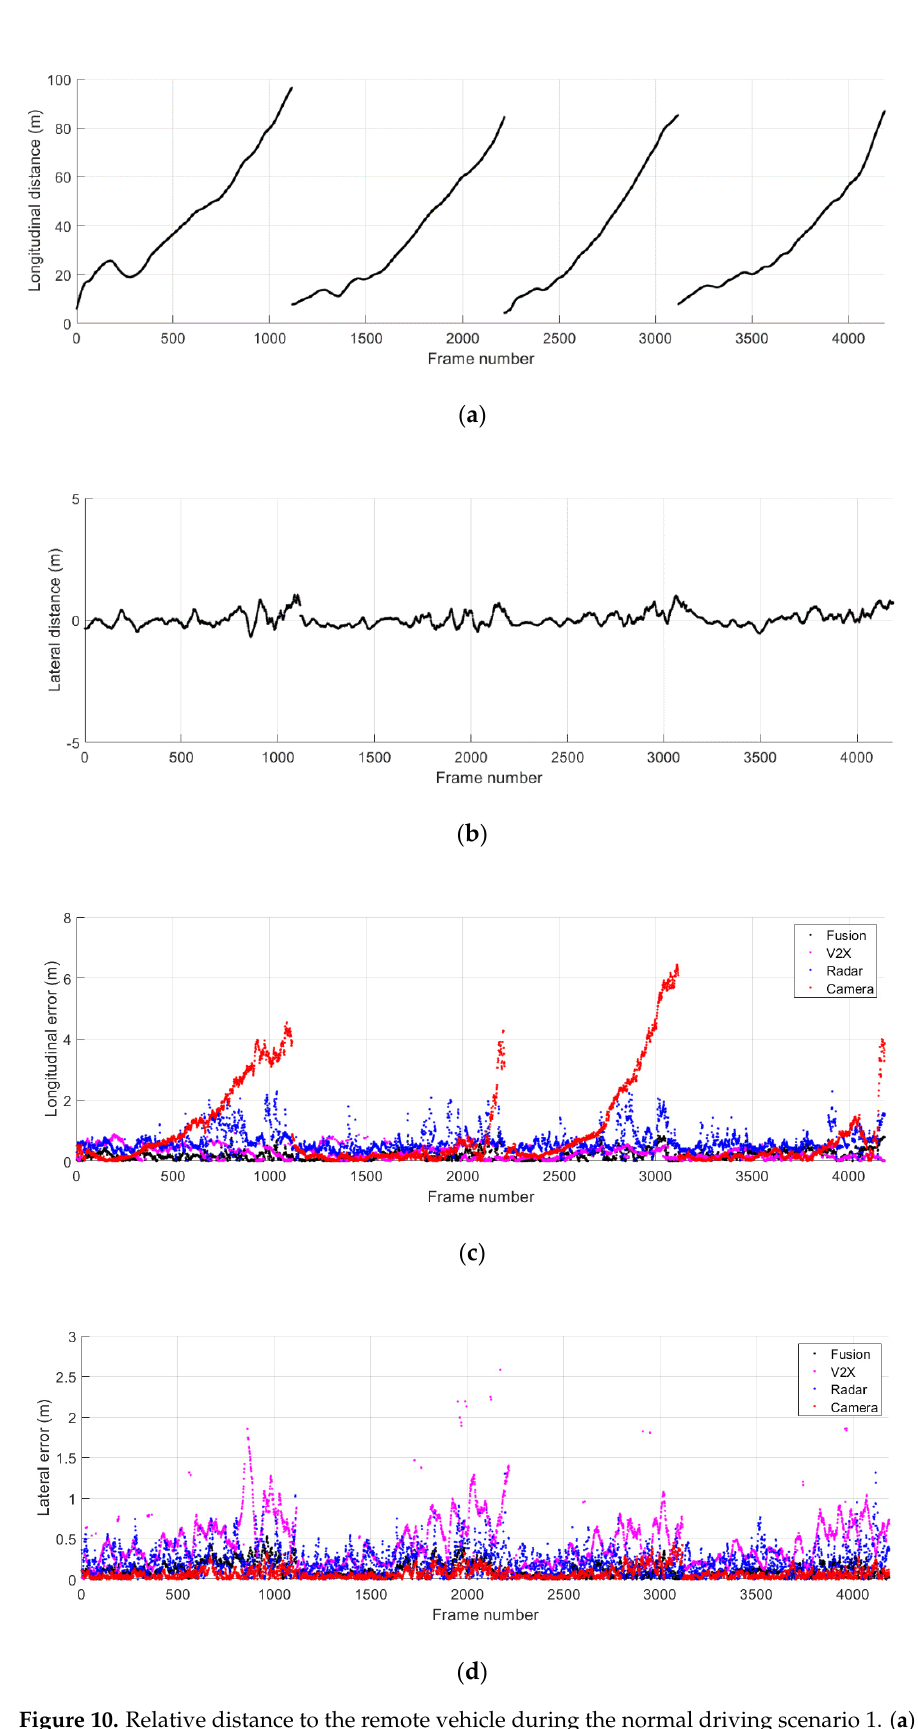
Figure 10. Relative distance to the remote vehicle during the normal driving scenario 1. ( a ) Ground truth longitudinal distance; ( b ) ground truth lateral distance; ( c ) absolute error for longitudinal distance estimates; ( d ) absolute error for lateral distance